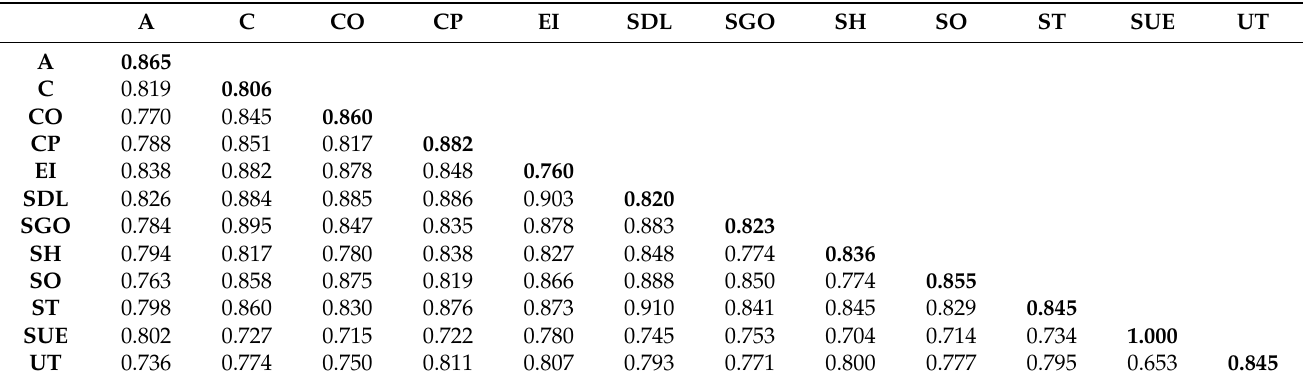
Table 6. Discriminant Validity (Fornell and Larcker